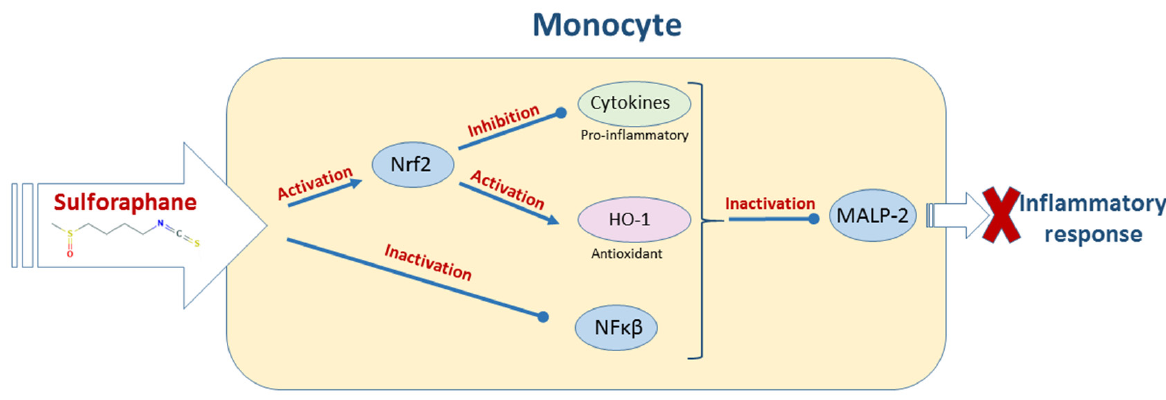
Figure 3. Mechanism of inflammatory response suppression induced by sulforaphane in bacteria-infected monocytes.